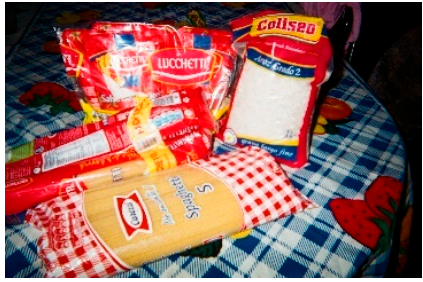
Figure 2. Usual food that she has in the pantry.